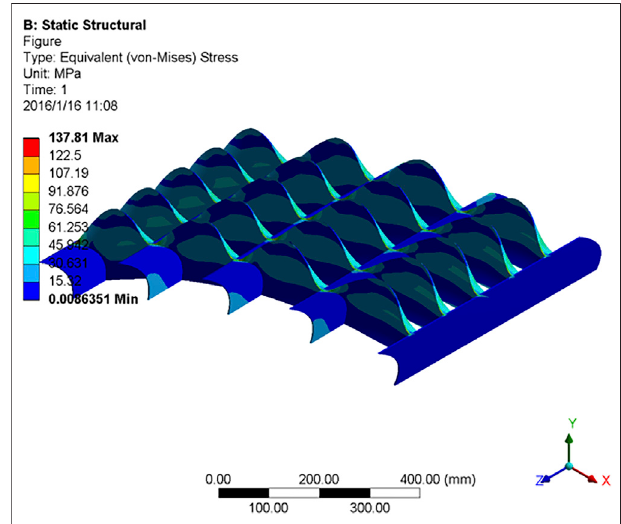
FIGURE 14 | The equivalent stress distribution.